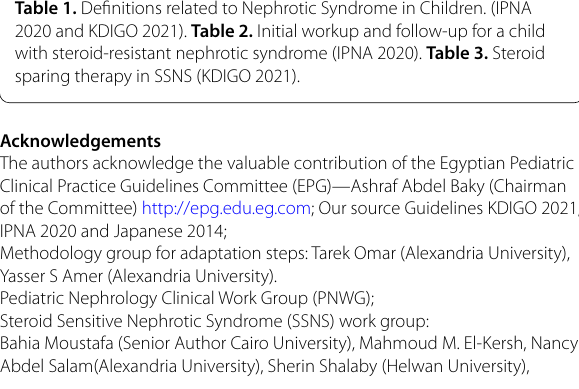
Table 1. Definitions related to Nephrotic Syndrome in Children. (IPNA 2020 and KDIGO 2021). Table 2. Initial workup and follow‑up for a